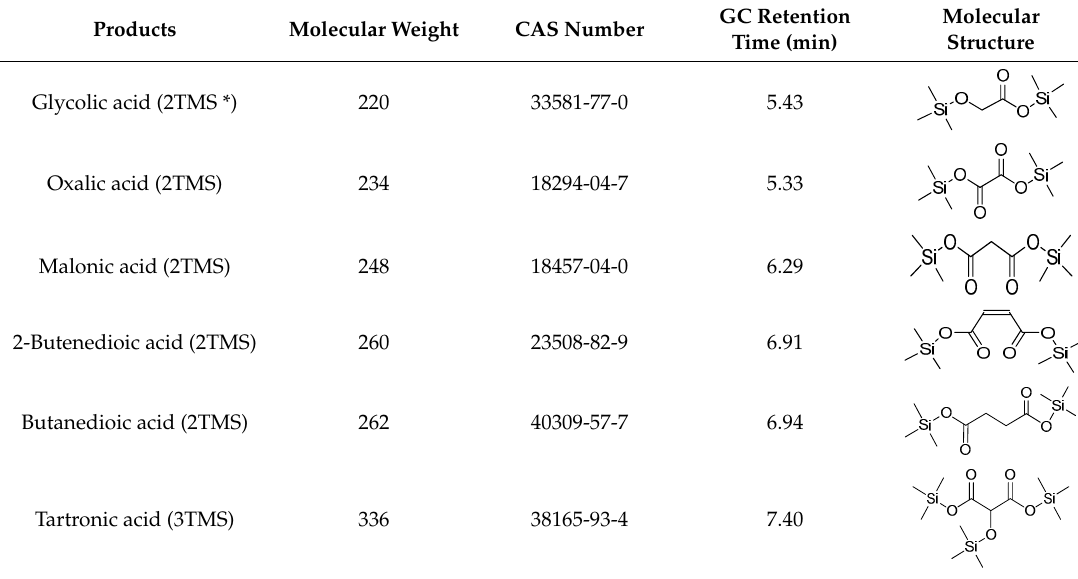
Table 7. Degradation products of HBP detected by GC/MS.